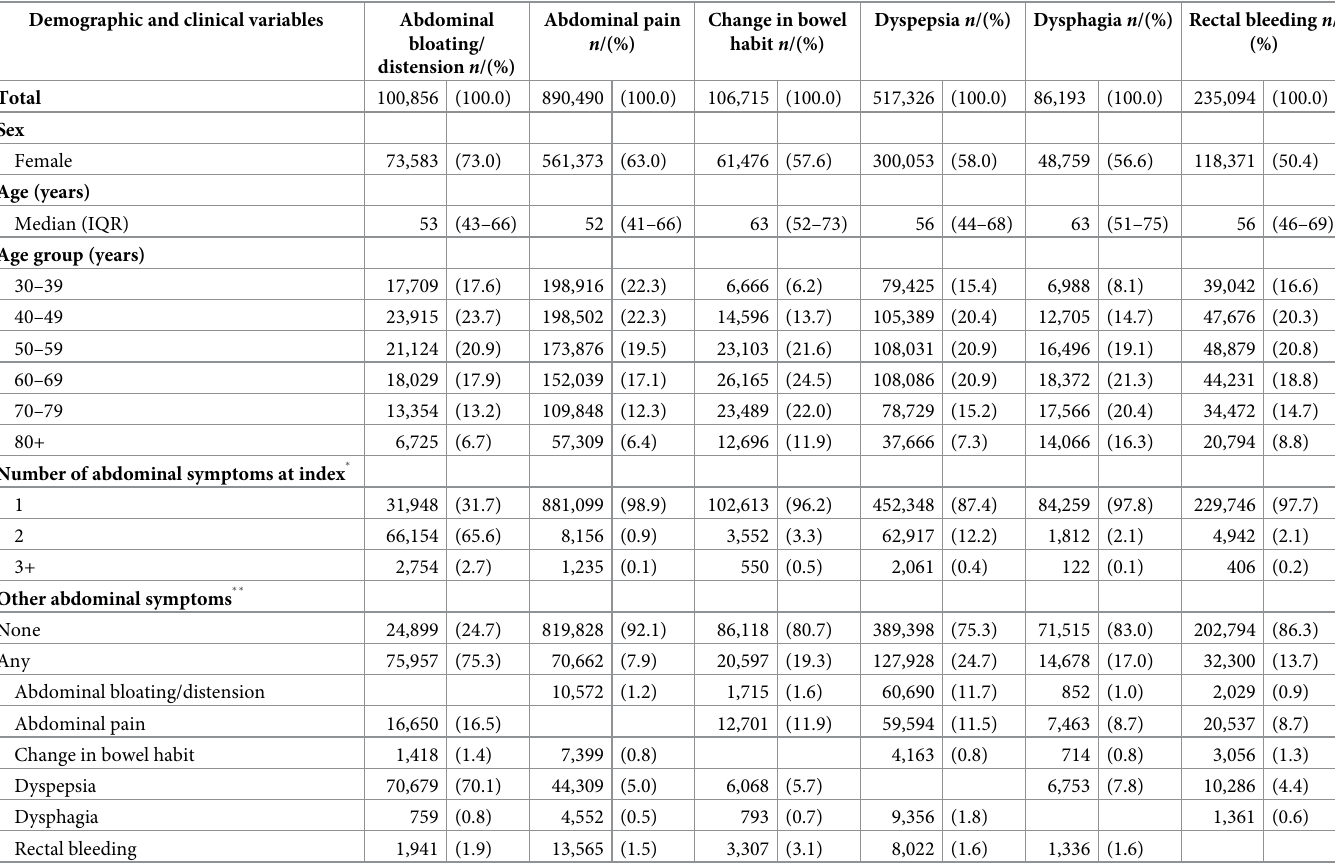
Table 1. Characteristics of patients per studied symptom cohort at time of index consultation, n